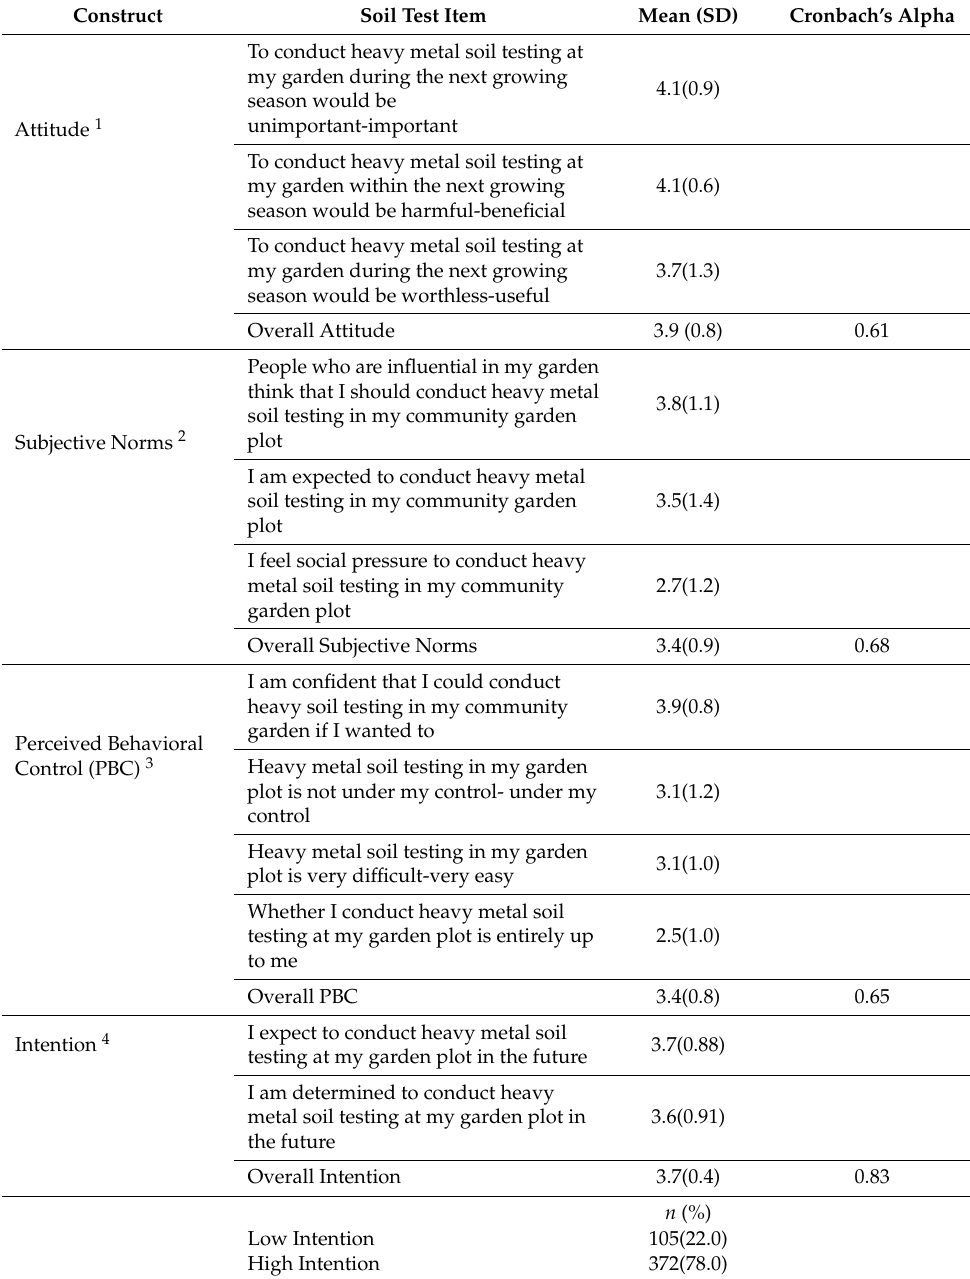
Table 3. Theory of Planned Behavior Constructs for Soil